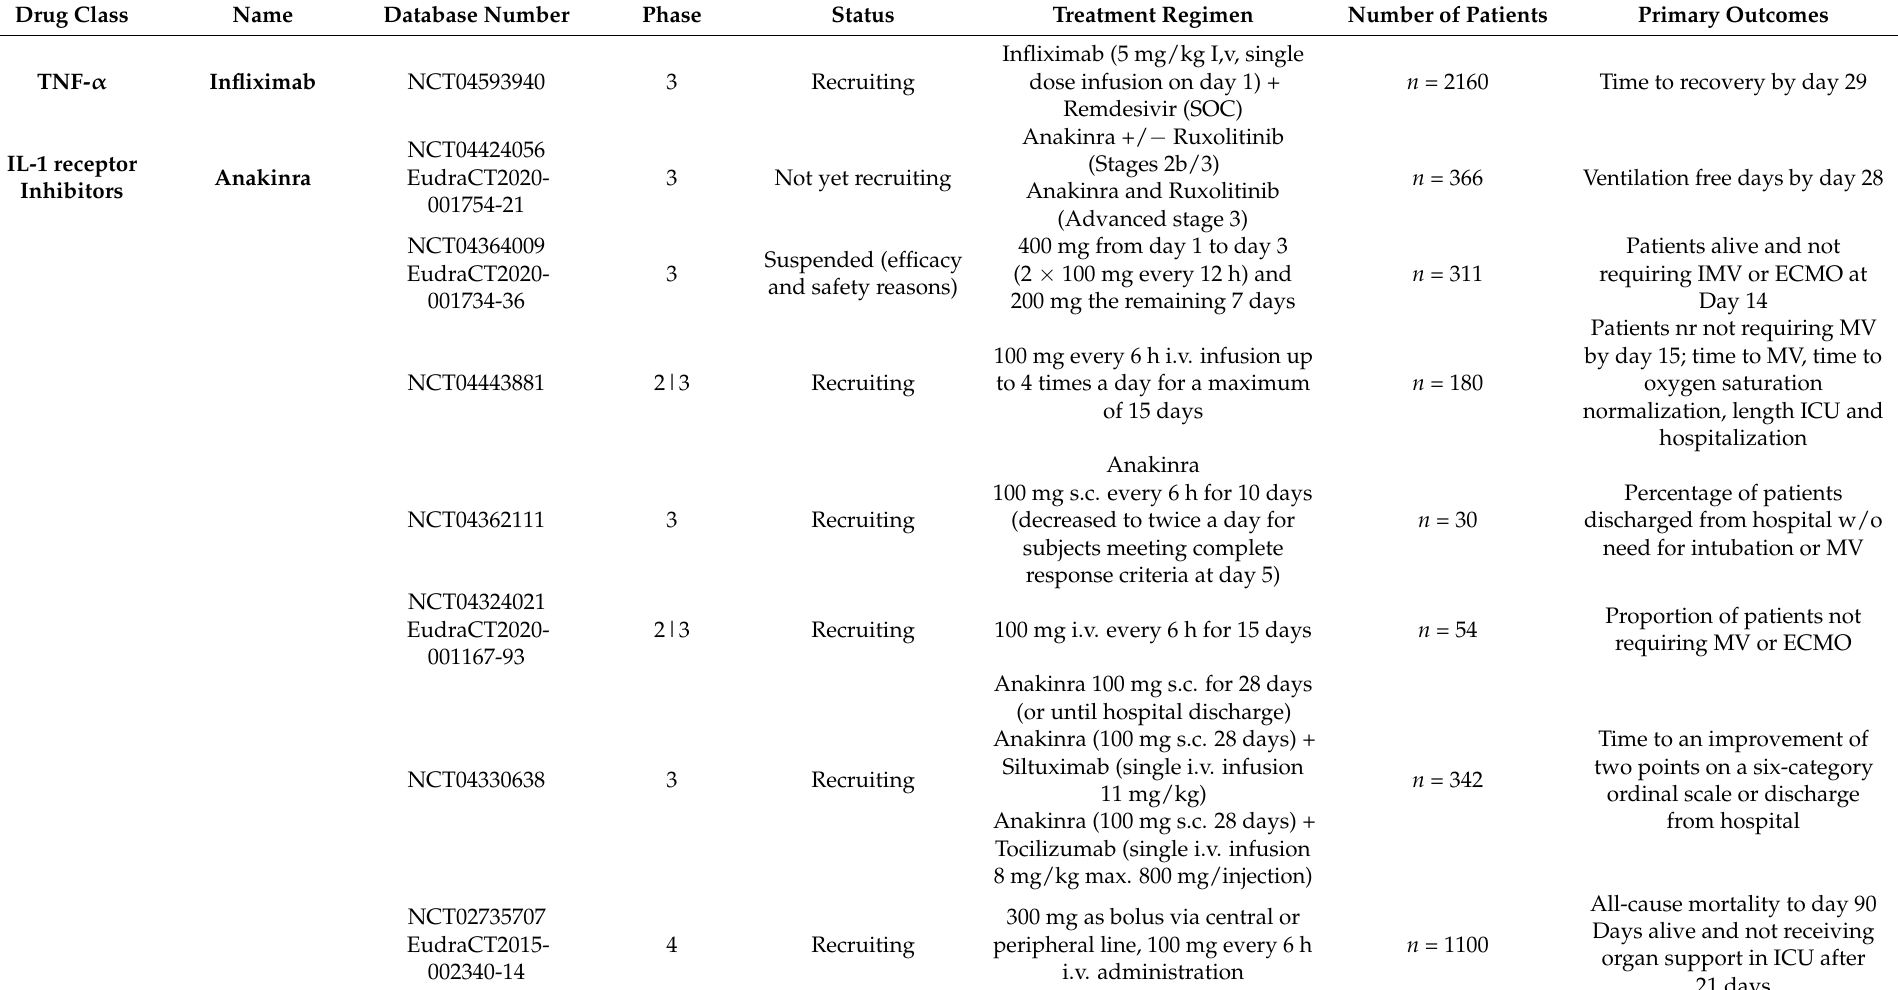
Table 2. Summary of selected therapeutic strategies targeting the cytokine storm in COVID-19 in phase 3 and 4 clinical trials registered on clinicaltrials.gov and clinicaltrialsregister.eu databases Abbreviations: SOC, standard of care; IMV, invasive mechanical ventilation; MV, mechanical ventilation; ICU, intensive care unit; ECMO, extracorporeal membrane